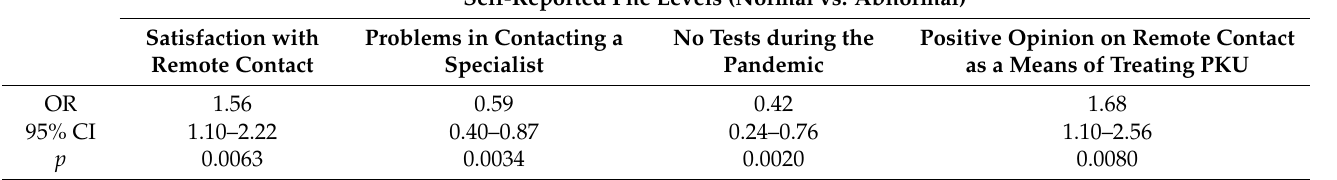
Table 4. Self-reported Phe levels (normal vs. abnormal) before the pandemic and the perception of remote visits, availability of specialists and the lack of control Phe tests during the